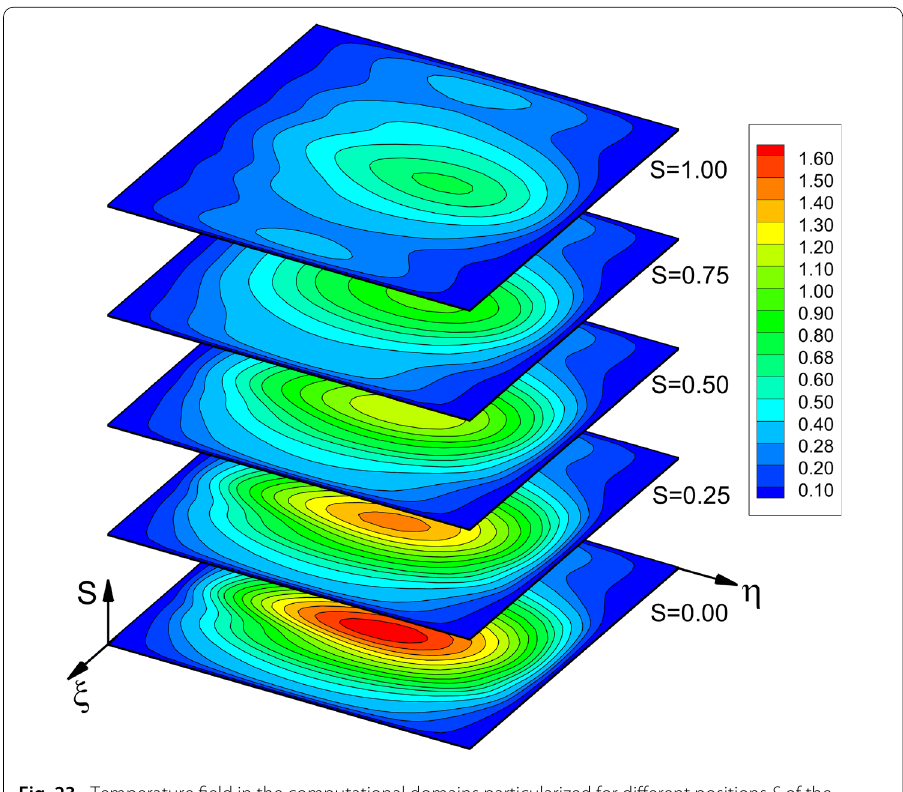
Fig. 23 Temperature field in the computational domains particularized for different positions S of the control point indicated in Fig. 22, that is, for different shapes of the physical domain